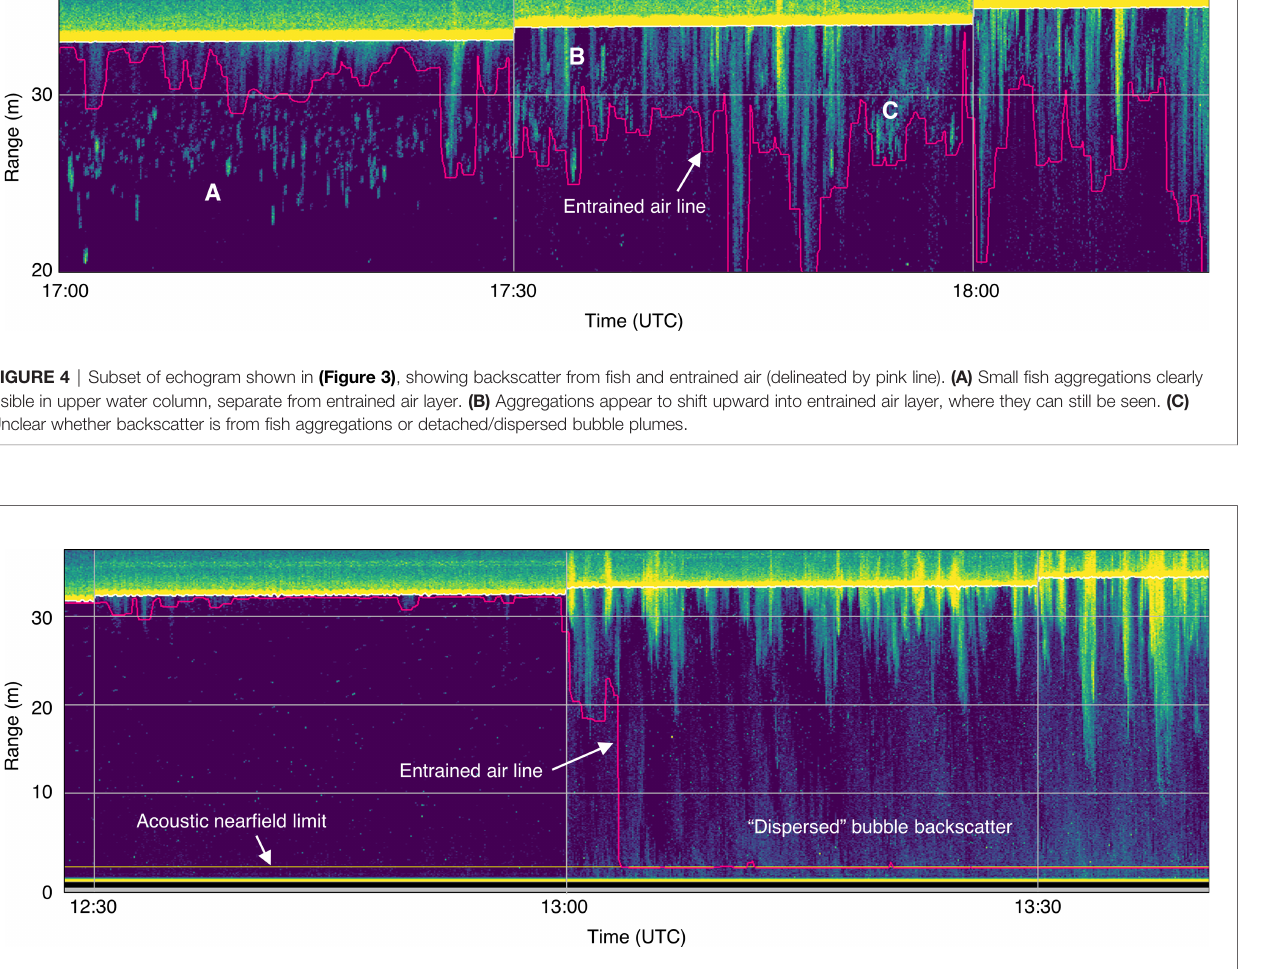
FIGURE 5 | Example of backscatter from bubbles entrained throughout the water column. The detected entrained air line (pink) extends to the acoustic near fi eld (horizontal yellow line), resulting in omission of most or all of the water